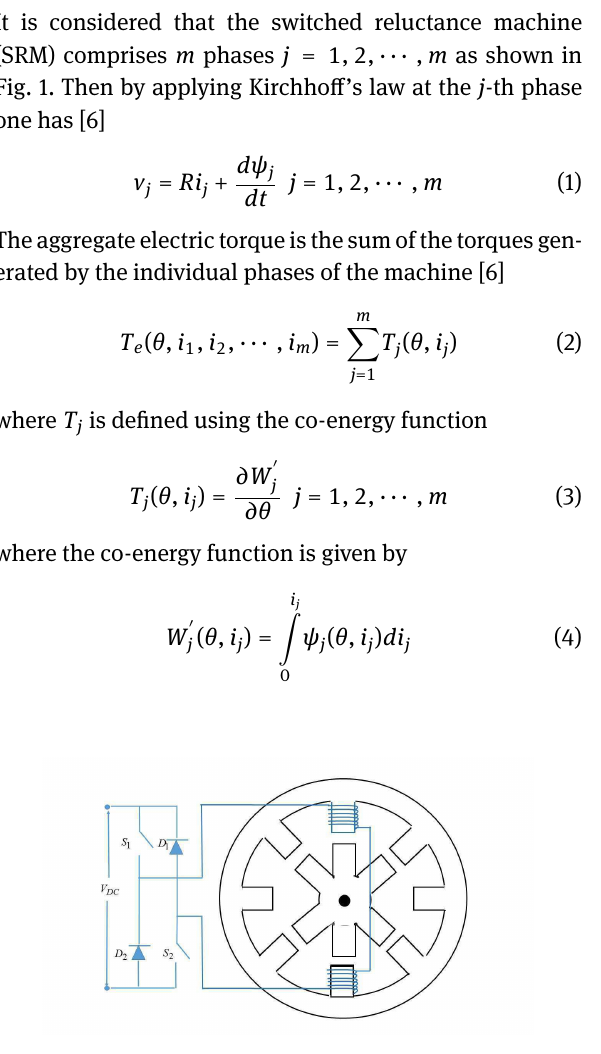
Fig. 1: Switched reluctance machine and its control